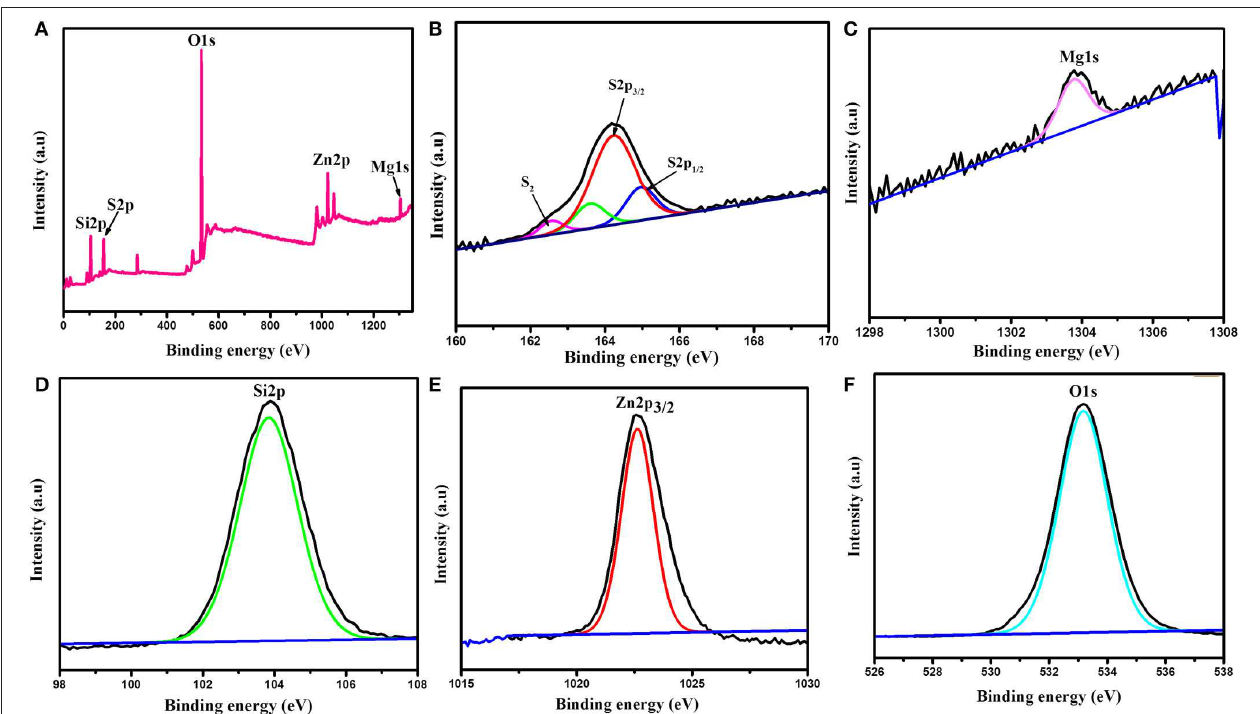
FIGURE 8 | XPS (A) Wide spectrum of S/PTSp/ZnO composite, Spectra of (B) S2p1/2 and S2P3/2, (C) Magnesium, (D) Silica, (E) Zn2p3/2, (F)